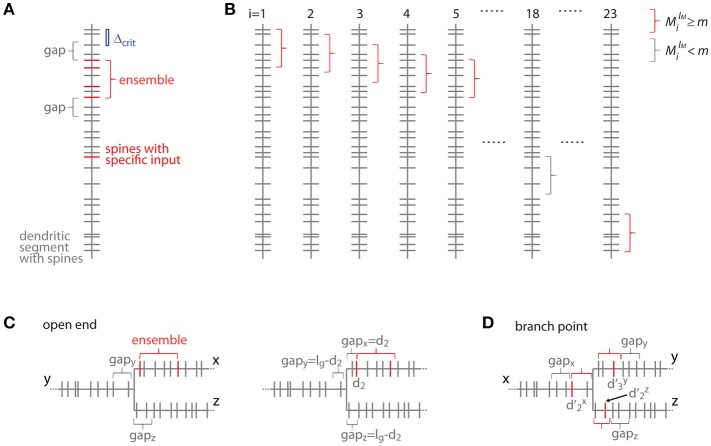
Transformation to the distance based case. (A) Example of a dendritic segment with irregularly spaced spines. 5 spines receive the specific input (red), 4 of which are part of an ensemble (red bracket), because they comply with the nearest neighbor distance criterion Δcrit (indicated by the blue bar). The length of the leading and trailing gaps, which flank the ensemble, correspond to the nearest neighbor distance criterion. No spine located within these gaps receives the specific input. (B) All possible placements of the given ensemble in (A) with length lM and m or more spines onto the dendritic segment. These are obtained by moving the particular ensemble length from spine to spine (i = 1, 2, 3, … 23). Ensembles which fulfill the condition that they contain m or more spines are marked with red and others with gray brackets, respectively. (C) Illustration of the open end condition in the distance based case. Left, situation when the ensemble is located at the beginning of segment x and the gap extends in its full length onto segments y and z. Right, the ensemble on segment x begins with the spine at a distance of d2 such that part of the gap is located on segment x and gaps of the remaining length are located on segments y and z. (D) Illustration of an ensemble at a branch point in the distance based case. The ensemble occupies all three segments x, y and z. Its total extend, i.e., the summed distances of the limiting spines relative to the branch point d'2x + d'3y + d'2z, has to fulfill the condition of being smaller or equal to the ensemble length lM. The ensemble is delimited on each segment by a gap.